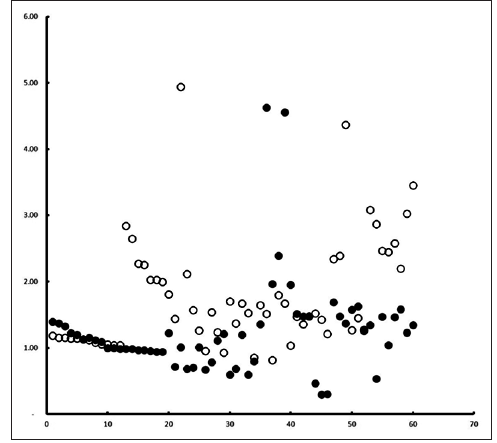
Figure-2: The scattered plot of bovine growth hormone level of serum of Bali cattle of female (filled circle) and male (unfilled circle) animals.